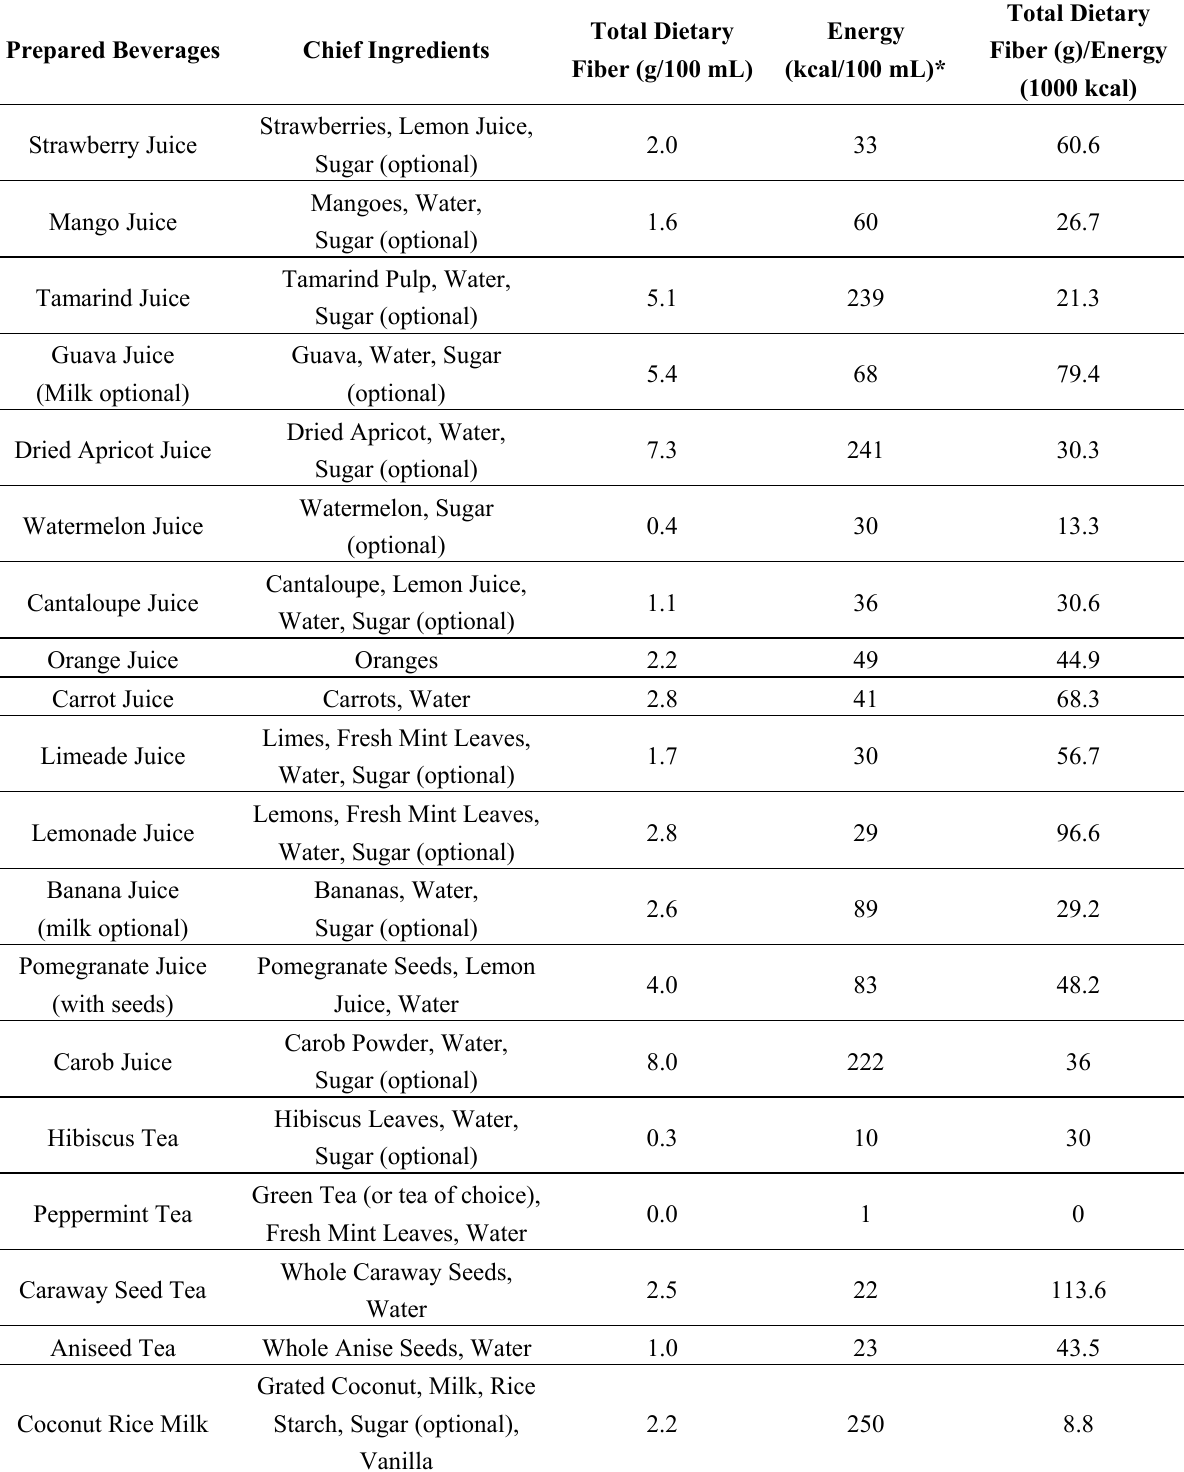
Table 1. Total Dietary Fiber (TDF) content of traditional Egyptian beverages (per 100